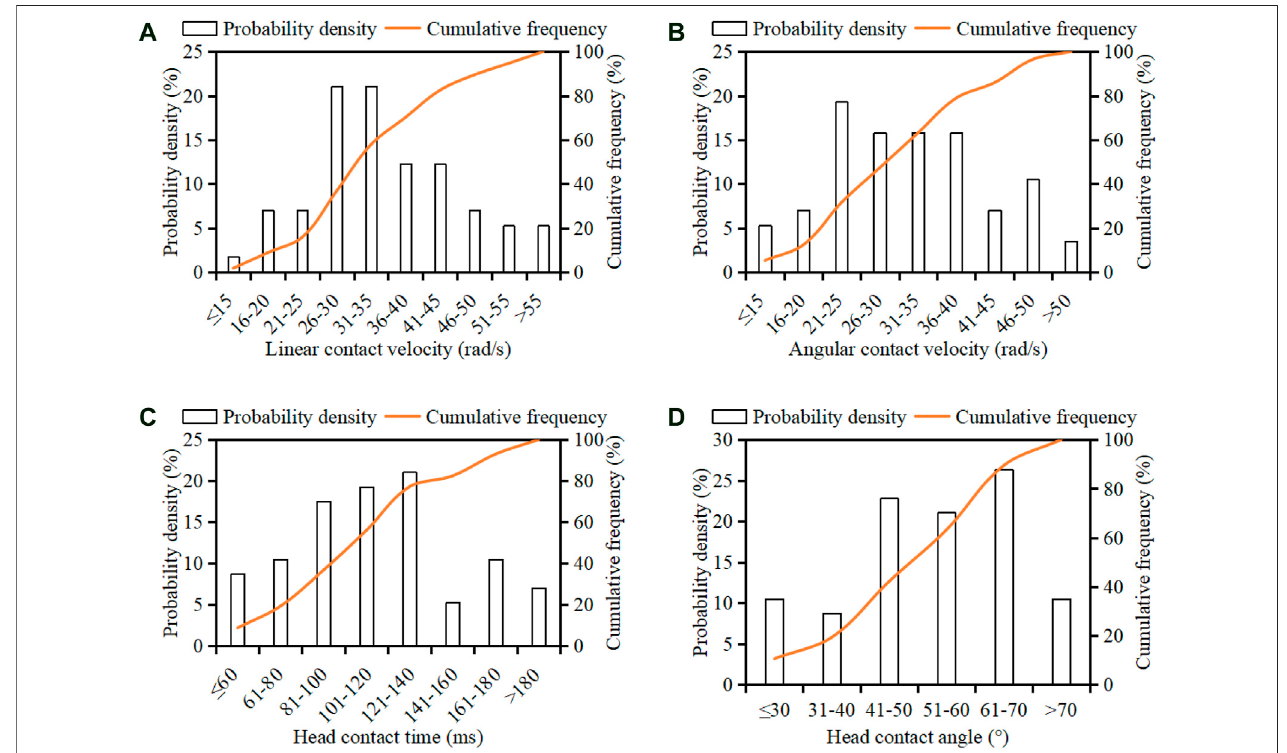
FIGURE 8 | Distribution of pedestrian head linear contact velocity (A) , angular contact velocity (B) , contact time (C) , and contact angle (D) .